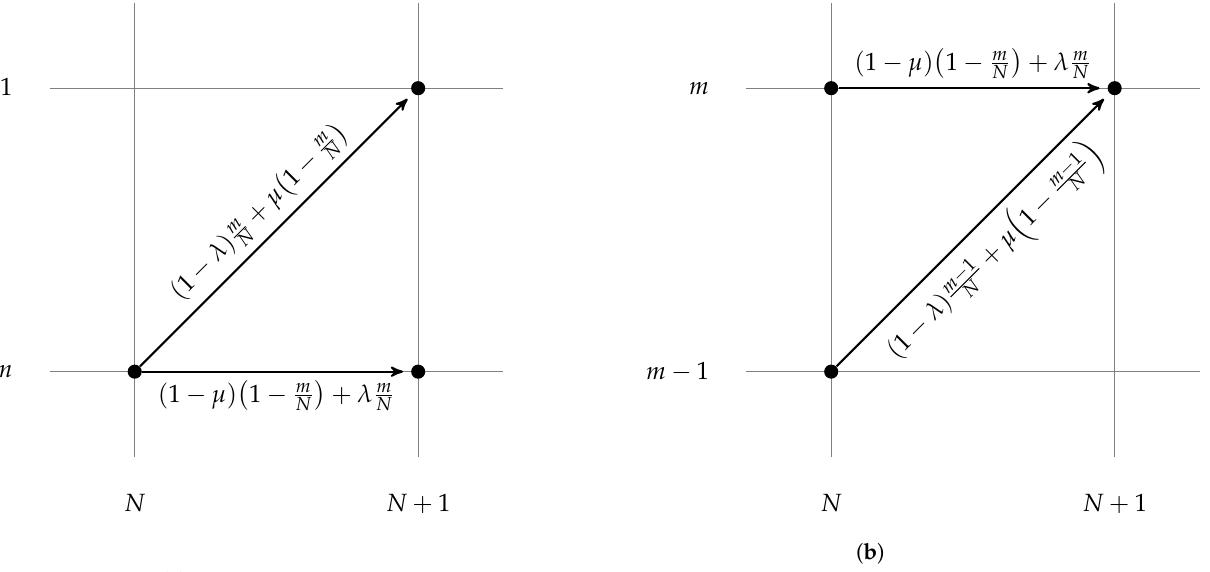
Figure 2. Forward and adjoint schematic illustrations of transitional probabilities in the Markov chain model. Parameters µ and λ are the resistance acquisition and loss probabilities, respectively. ( a ) Forward diagram: given a population of size N containing m resistant cells, the probabilities that one offspring becomes resistant or sensitive are illustrated. ( b ) Adjoint diagram: considering a population of size N + 1 containing m resistant cells, the probabilities of the two possible ways by which the state could have been reached are